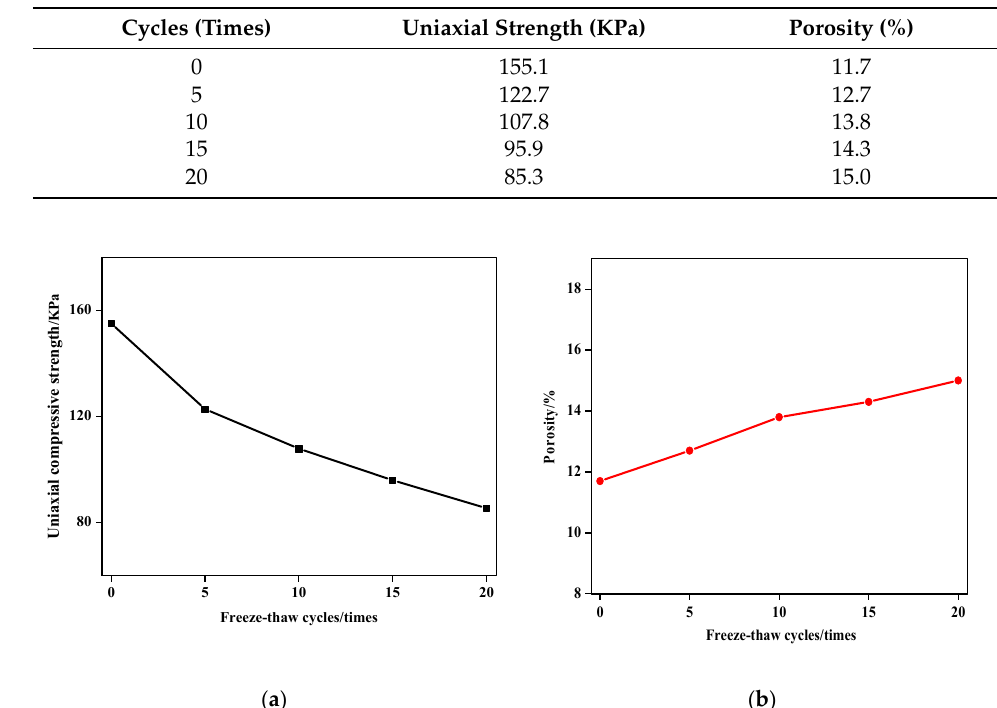
Table 4. Test results of coarse-grained soil strength and porosity.